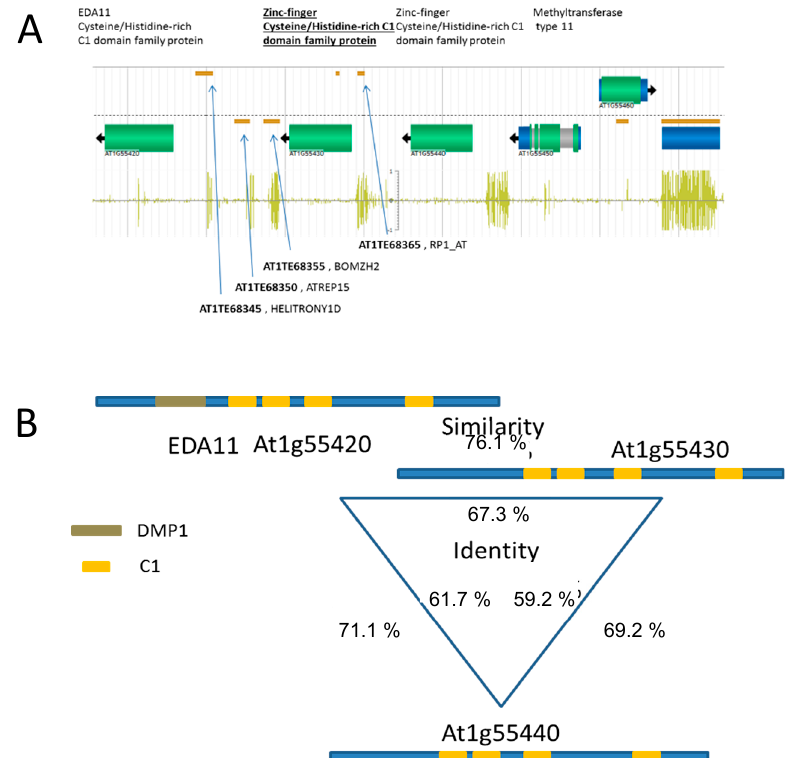
Figure 3. Region on chromosome 1 associated with the N use efficiency (NUE)-related growth trait QTL. ( A ) Schematic overview of the identified region encoding the genes AT1G55420 ( EDA11 ), AT1G55430 and AT1G55440 . Green: coding regions, arrows: orientations of the genes, grey: introns, blue: untranslated transcribed regions, orange: loci with similarity to repetitive structures. The lower line indicates DNA methylation, analysed by whole genome bisulfite sequencing in the reference accession Col-0 . Data derived from GoGe Genome viewer. ( B ) Comparison of domain structure, similarity and identity of proteins encoded by AT1G55420 ( EDA11 ), AT1G55430 and AT1G55440 . DMP1: similar to dentin matrix protein 1, C1: cysteine-rich C1 domain with affinity to DAG (diacylglycerol). Identity between the genes is indicated (%) inside the triangle, with similarity outside.